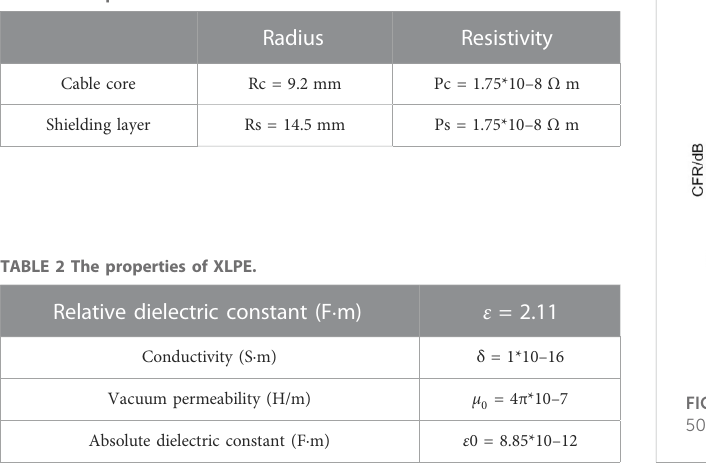
TABLE 1 The parameters of XLPE cable.